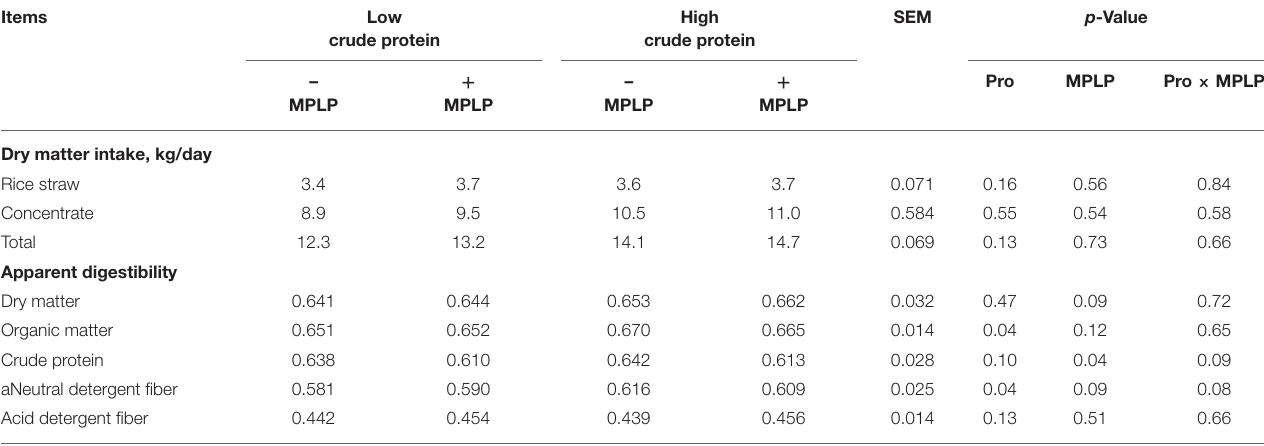
TABLE 2 | Effect of crude protein level and mangosteen peel liquid-protected soybean meal on voluntary feed intake and apparent digestibility in lactating dairy cows. Items